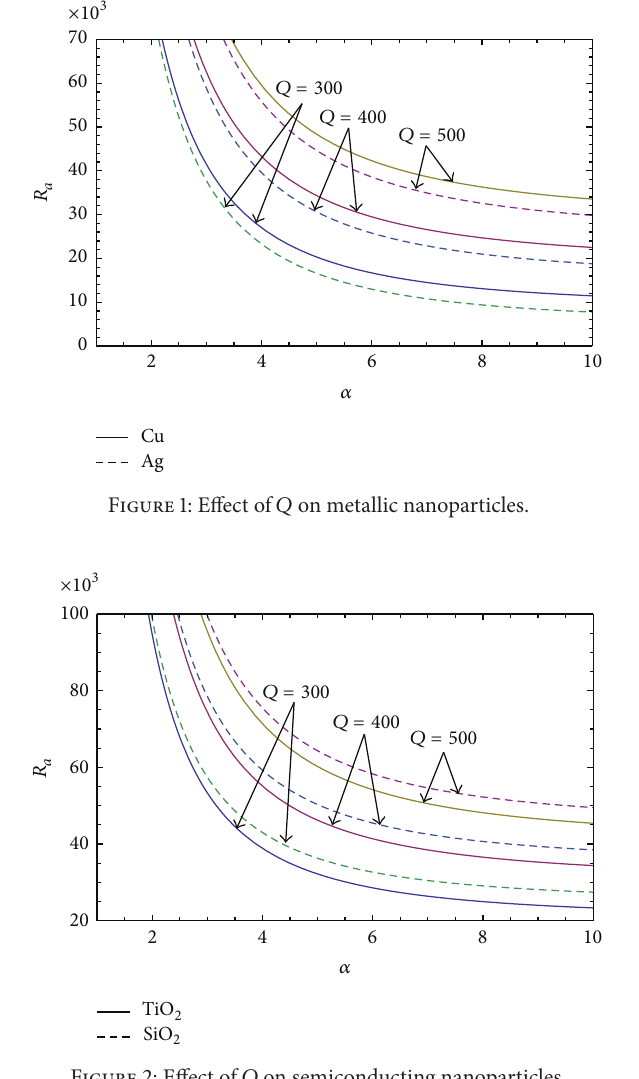
Figure 2: Effect of 𝑄 on semiconducting nanoparticles.